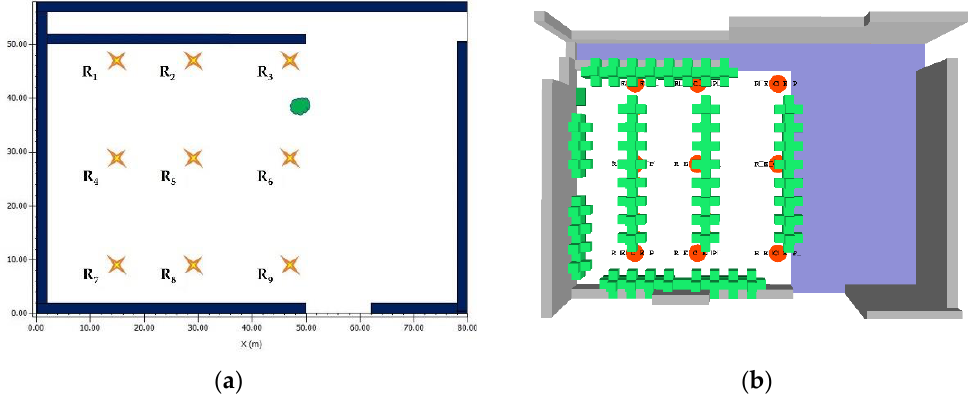
Figure 6. Layout of the ENVI-Met model and the receptors: ( a ) 2D visualization; ( b ) 3D visualization.